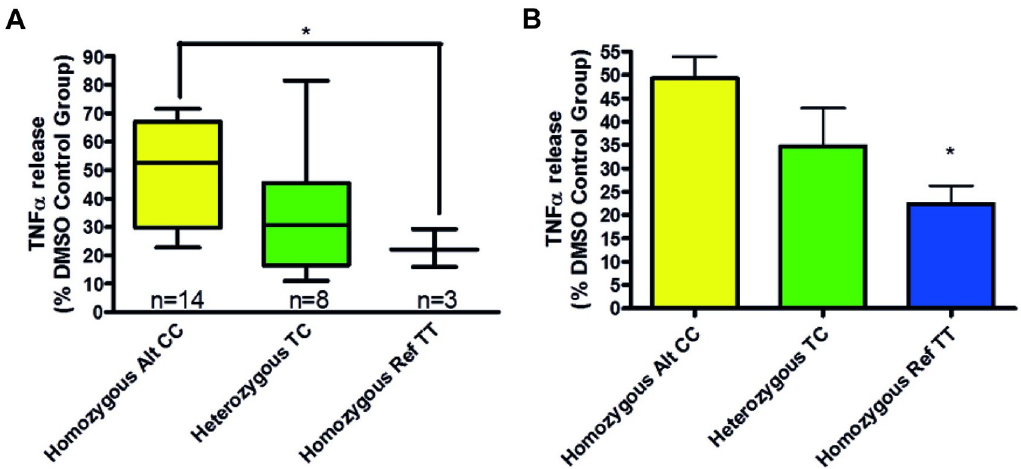
Fig 5. Graphs showing the relationship between CYP2E1 SNP rs2249695 genotype and TNF α release from stimulated human lung parenchyma biopsies following roflumilast and fluticasone co-treatment. Data is displayed as a percentage of the corresponding DMSO control group. Asterisks indicate significant differences (p < 0.05, for one, p < 0.01 for two and p < 0.001 for three). A: Box and whiskers graph depicting TNF α release. The 25th and 75th percentiles of each group are represented by the box with the minimum and maximum values represented by bars, the line within each box denotes the median value. B: Bar graph depicting mean + SEM TNF α release.